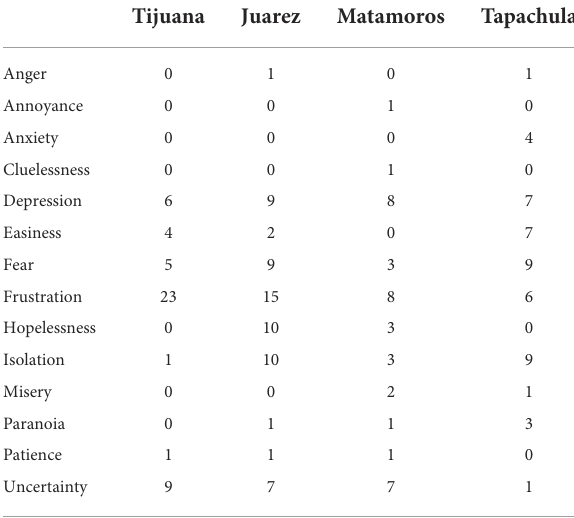
TABLE 2 Quotations during the interviews regarding mental